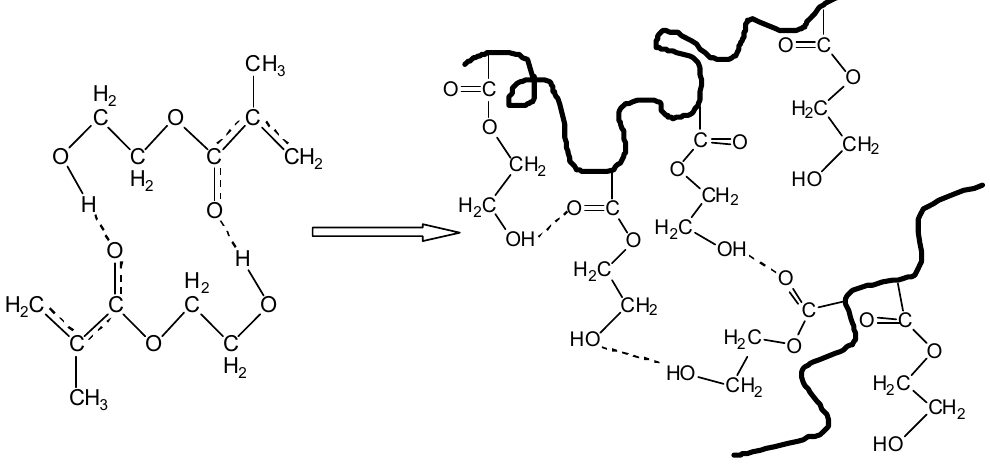
Scheme 1. Schematic illustration of the polymerization of HEMA to PHEMA and the intra- and inter-chain hydrogen bonds formed.